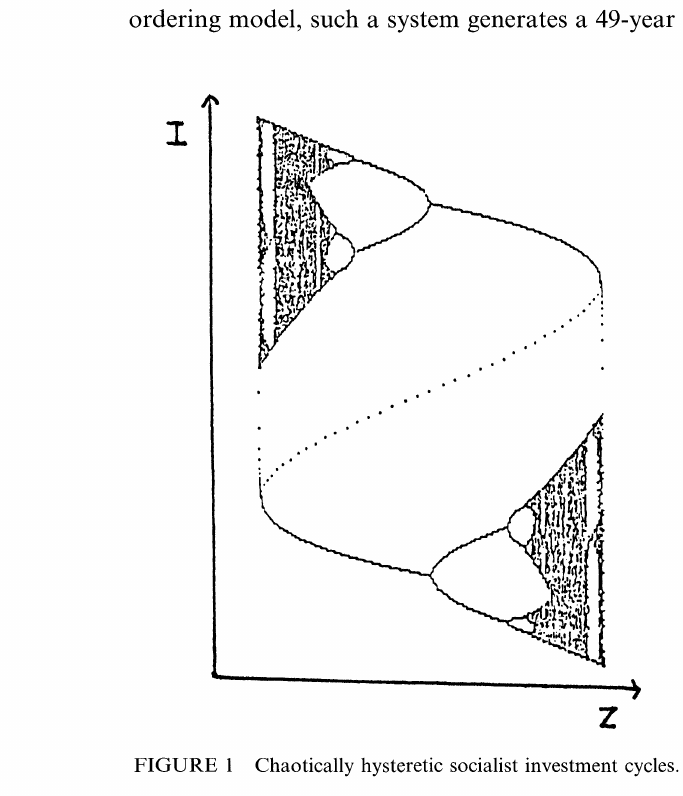
FIGURE Chaotically hysteretic socialist investment